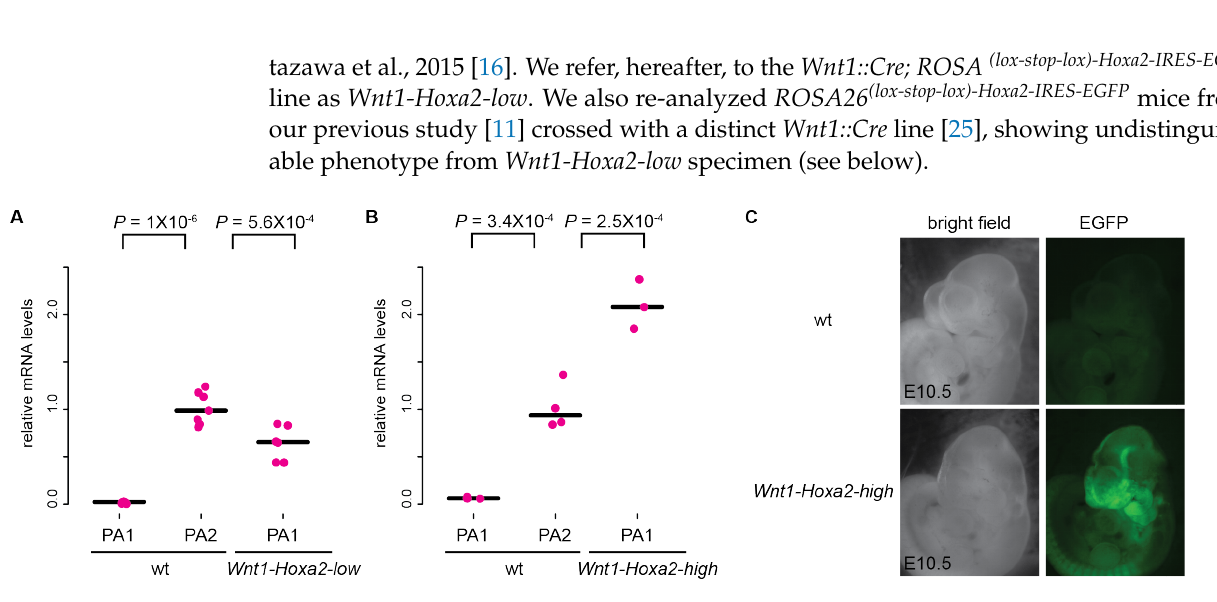
type (wt) embryos and in PA1 of Hoxa2 overexpressing embryos. Hoxa2 mRNA levels were normal- Figure 1. Ectopic Hoxa2 expression in Wnt1-Hoxa2-low and Wnt1-Hoxa2-high mouse embryos. ized by comparing with Gapdh mRNA. Data are from n = 7 (wt in A ), n = 6 ( Wnt1-Hoxa2-low in A ), n ( A , B ) Quantification of ectopic Hoxa2 mRNA expression levels in E10.5 Wnt1-Hoxa2-low ( A ) = 4 (wt in B ) and n = 3 ( Wnt1-Hoxa2-high in B ) biologically independent samples. p -values are from analysis of variance followed by Tukey’s HAD post hoc tests, and bars indicate the median. ( C ) E10.5 wt (top) and Wnt1-Hoxa2-high (bottom) embryos in bright field (left) and EGFP (right) signals. PA, pharyngeal arch.